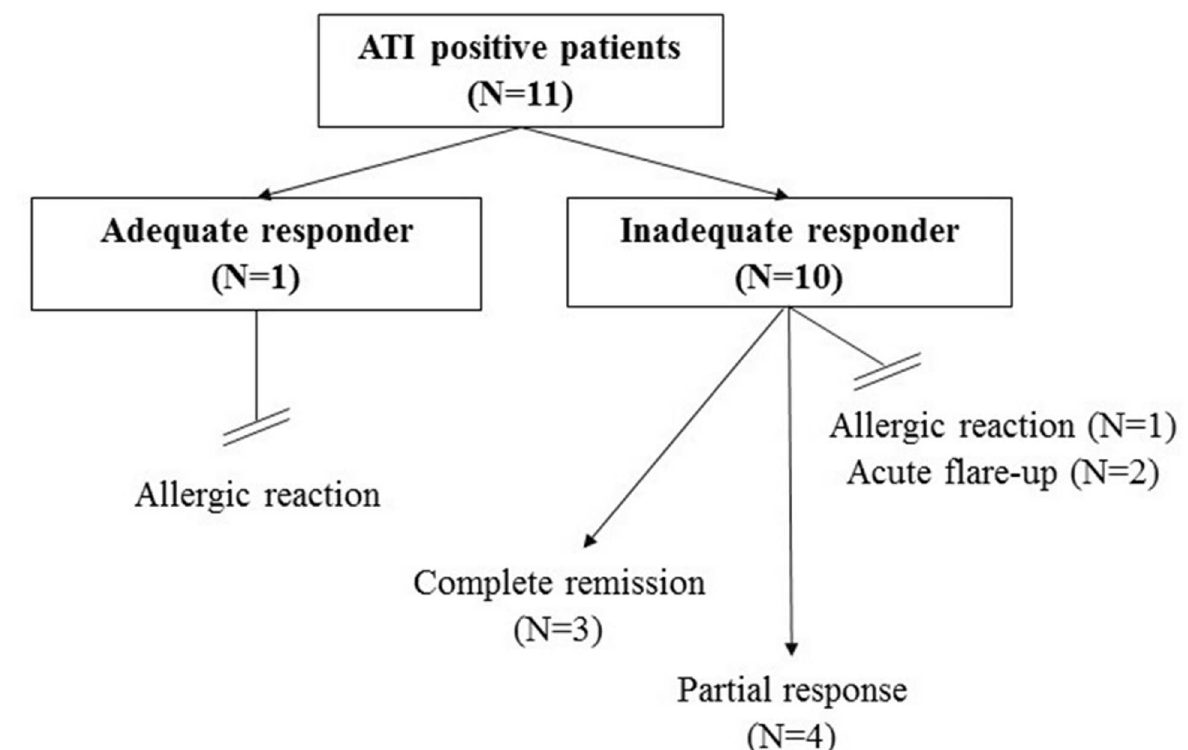
Fig 5. Antibody-to-infliximab (ATI) positive casesafter 6-months follow-up.